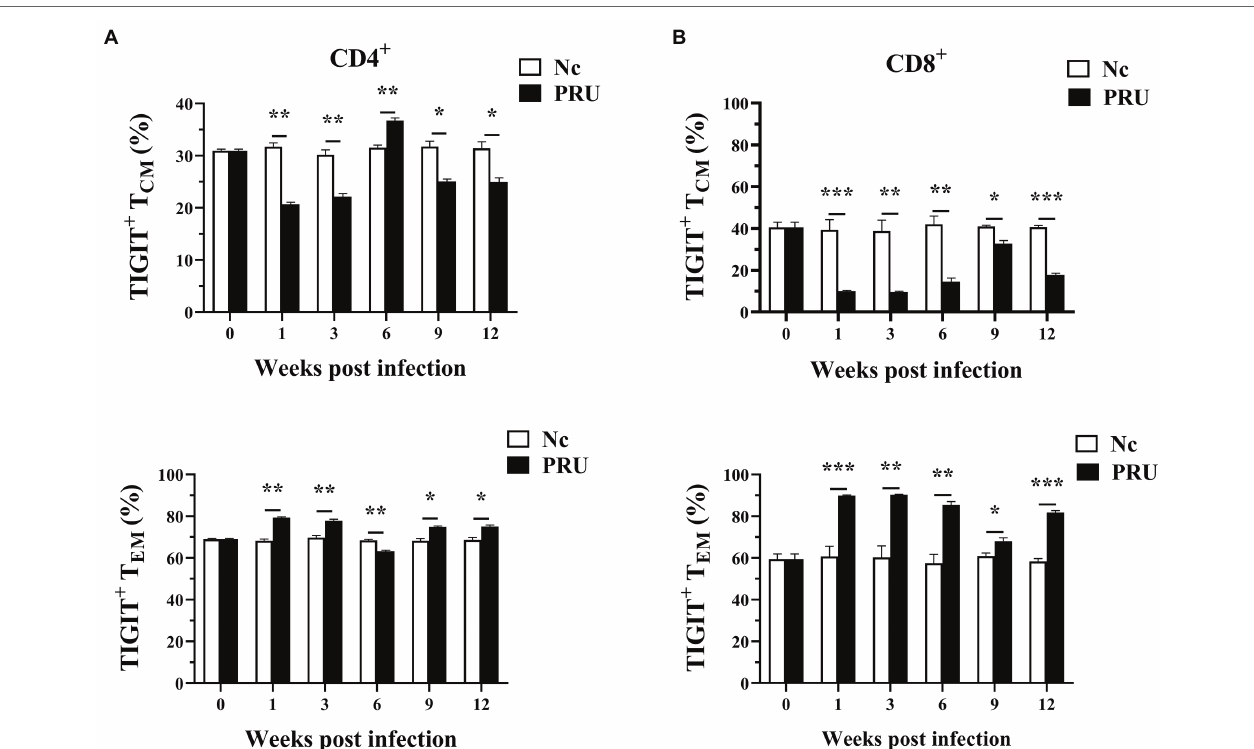
FIGURE 4 | Relative contributions of memory splenic T cell subsets to TIGIT + T cells after T. gondii infection. (A) Dynamic changes in memory T cell subsets of TIGIT + CD4 + T cells in the spleen at different time points following PRU infection. (B) Dynamic changes in memory T cell subsets of TIGIT + CD8 + T cells in the spleen at different time points following PRU infection. The results are representative of three independent experiments with five mice in each group per experiment, with data denoting means ± SDs. * p < 0.05, ** p < 0.01, and *** p < 0.001 (compared to the